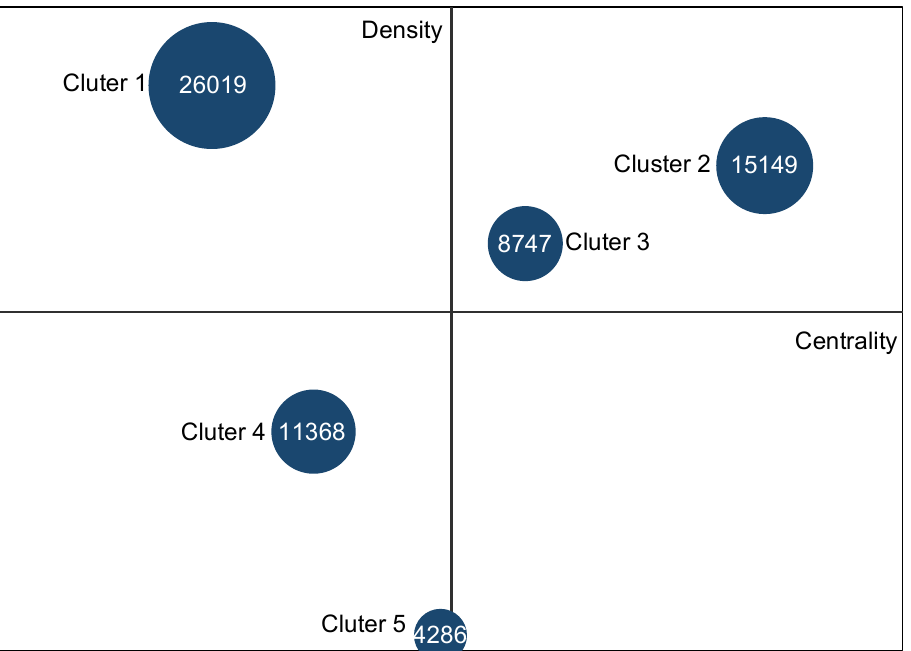
Figure 4. Strategic diagram based on number of papers published.